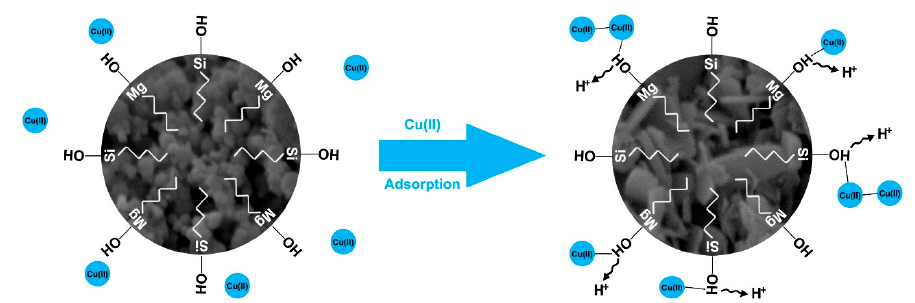
Figure 6. Illustration of the copper removal mechanism.